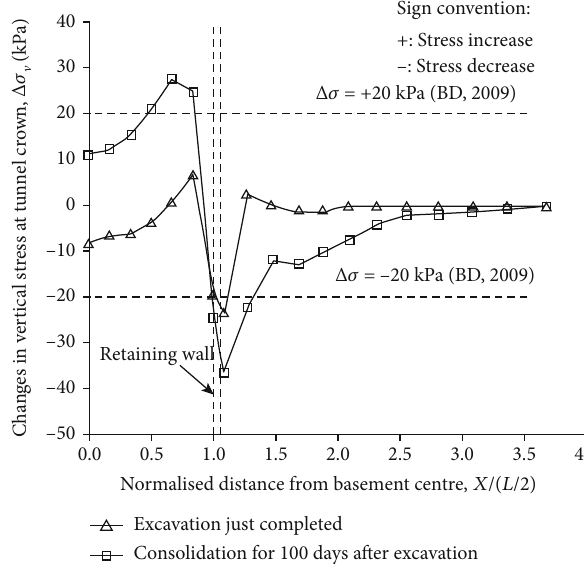
Figure 3: Vertical stress change in soil at tunnel